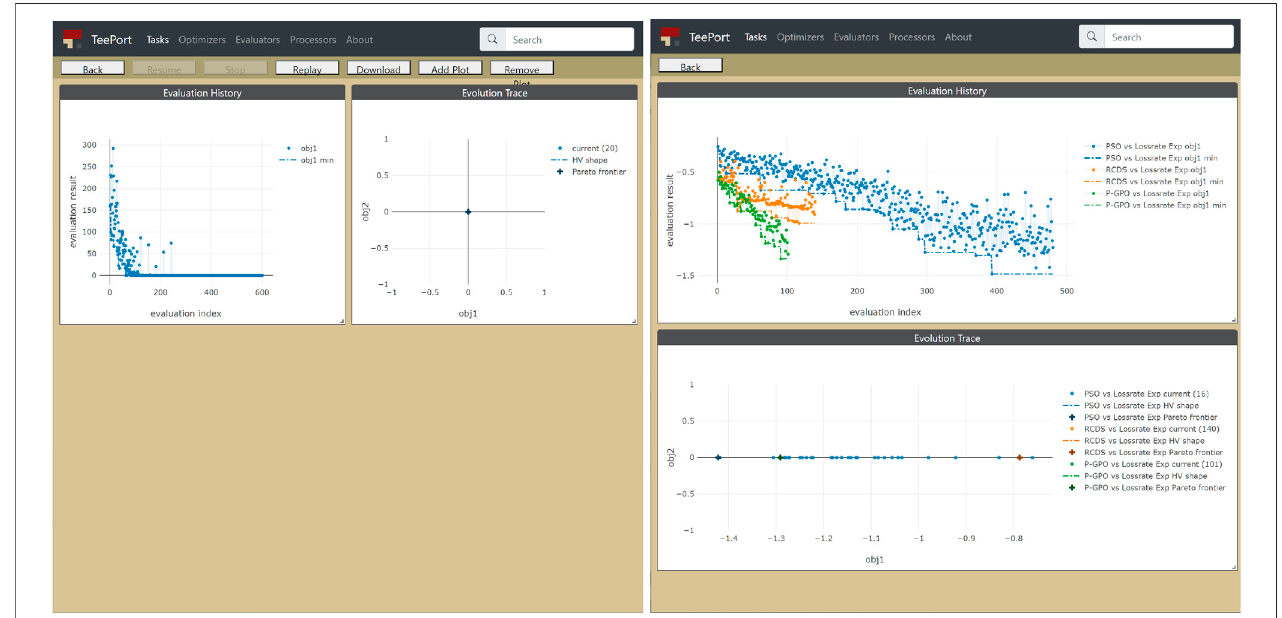
FIGURE 2 | Left: the history data of an online optimization experiment that was performed through Teeport; Right: comparison among the performance of three optimization algorithms against the SPEAR3 beam loss rate online optimization problem.